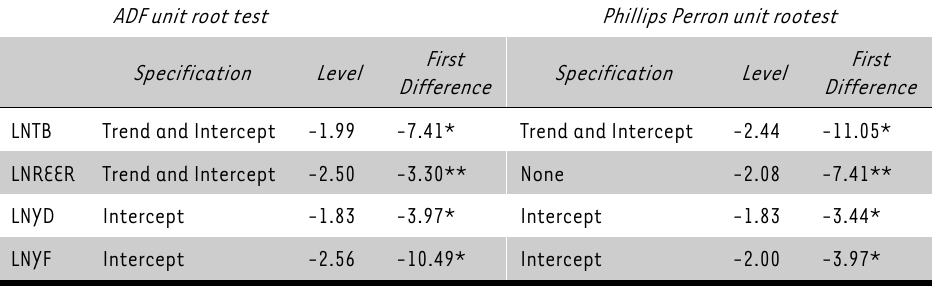
TABLE 1: Unit root